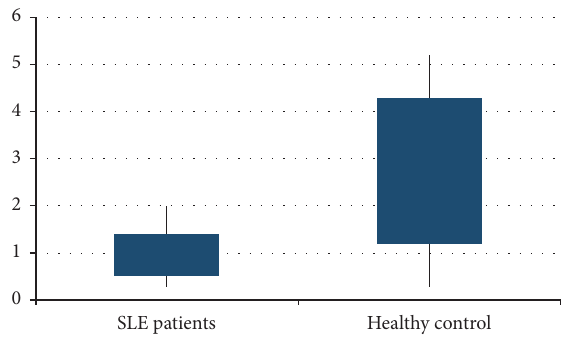
Figure 2: Box-plot analysis for Lactobacillus abundance among SLE patients and healthy controls. Table 4: Correlation between disease severity and target fecal microbiota in SLE patients.